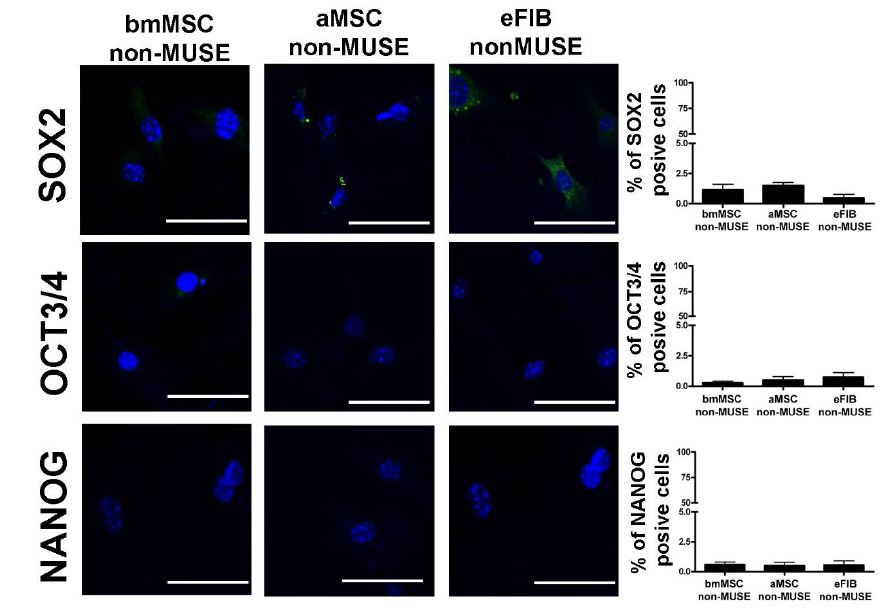
Figure 5. Stem cell markers in non-MUSE cells. The pictures are representative images of immunocytochemistry for stemness markers: SOX2, OCT3/4, and NANOG, performed on bmMSC-non-MUSE, aMSC-non-MUSE and eFIB-non-MUSE. The nuclei were counterstained with DAPI (blue). The histograms show the percentage of SOX2, OCT3/4, and NANOG-positive cells. The data are expressed with standard deviation ( n = 5). Scale bar = 50 μm.